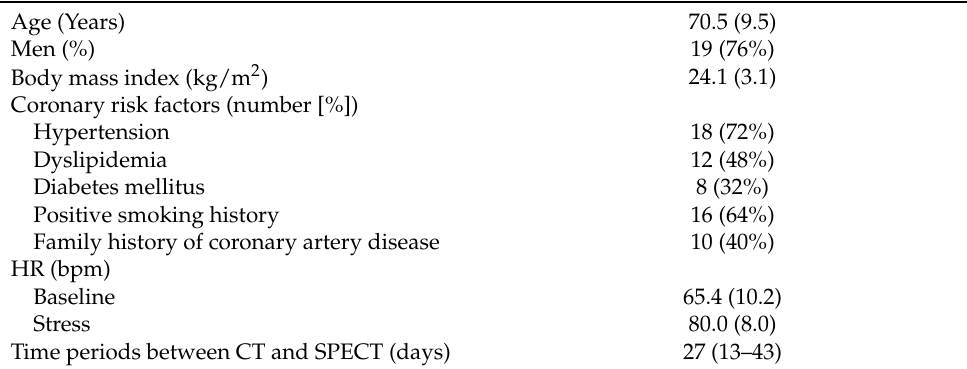
Table 1. Patient